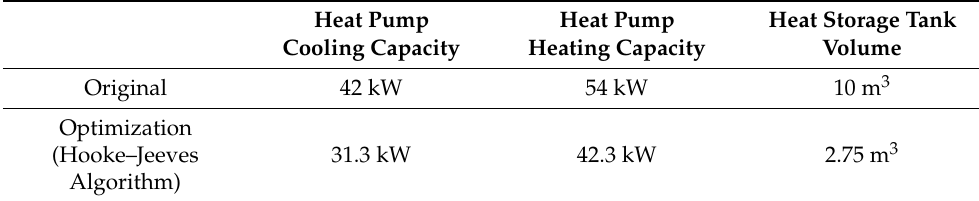
Table 6. Optimization results of capacity and